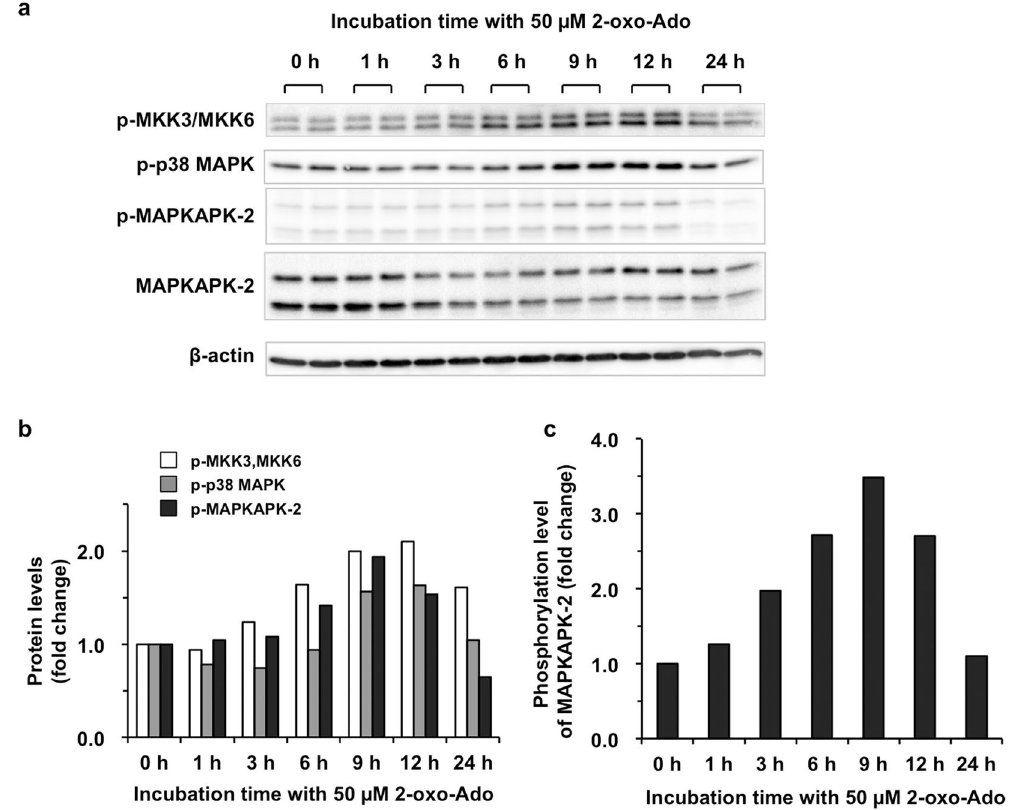
Figure 4. 2-Oxo-Ado activates the p38 MAPK pathway. ( a ) Protein levels of T9 cells were determined by western blot analysis after incubation with 50 µ M 2-oxo-Ado for various times. Ten micrograms of total protein was applied to each lane. p-; phosphorylated. ( b , c ) Quantification of protein levels in ( a ). Results are normalized against β -actin in ( b ), and relative values (fold change) of protein ( b ) or phosphorylation levels ( c ) to those at time 0 are shown as the mean of two